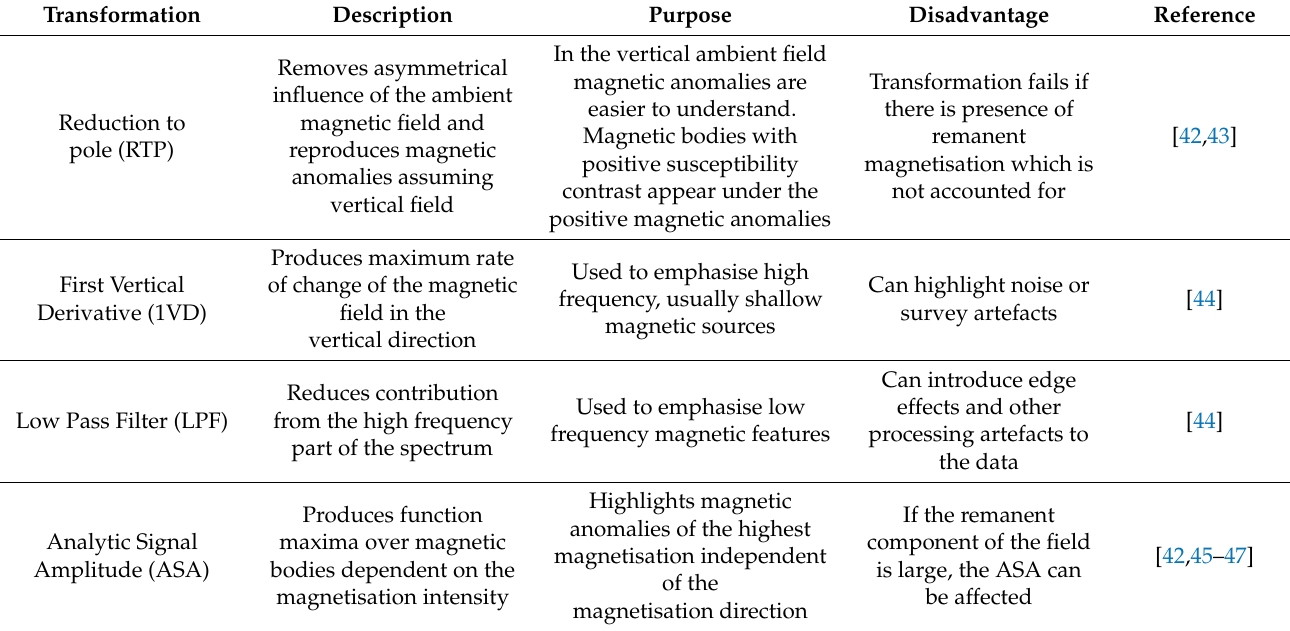
Table 1. Magnetic signal transformation